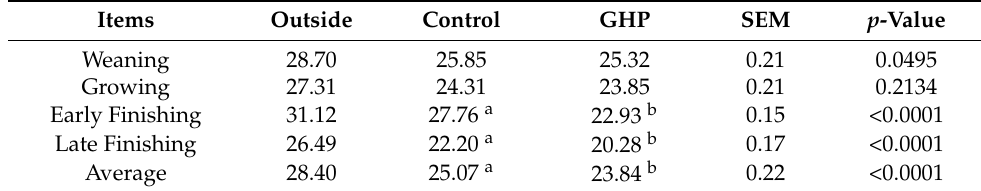
Table 2. Effect of the GHP cooling mode on the inside temperature of the pig house. Items